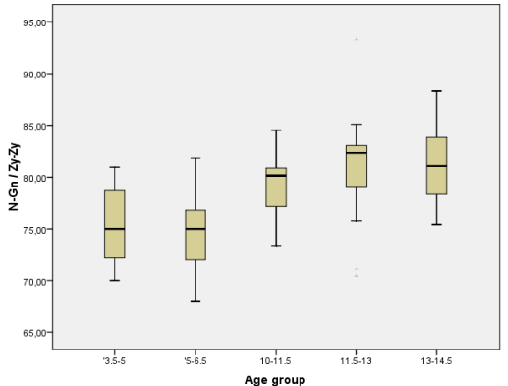
Figure 8. Boxplot for Tr-Gn values.